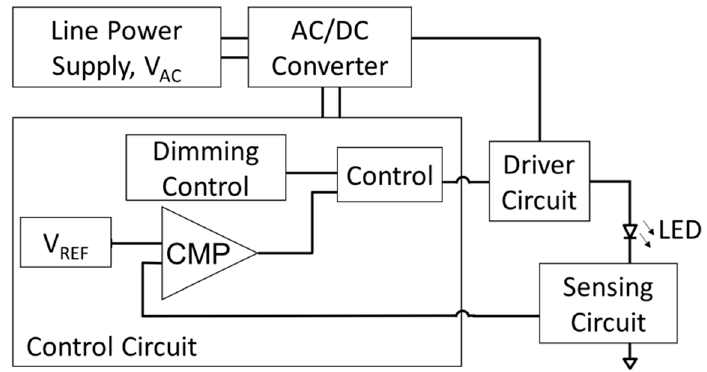
Figure 1. System block diagram of LED lighting.